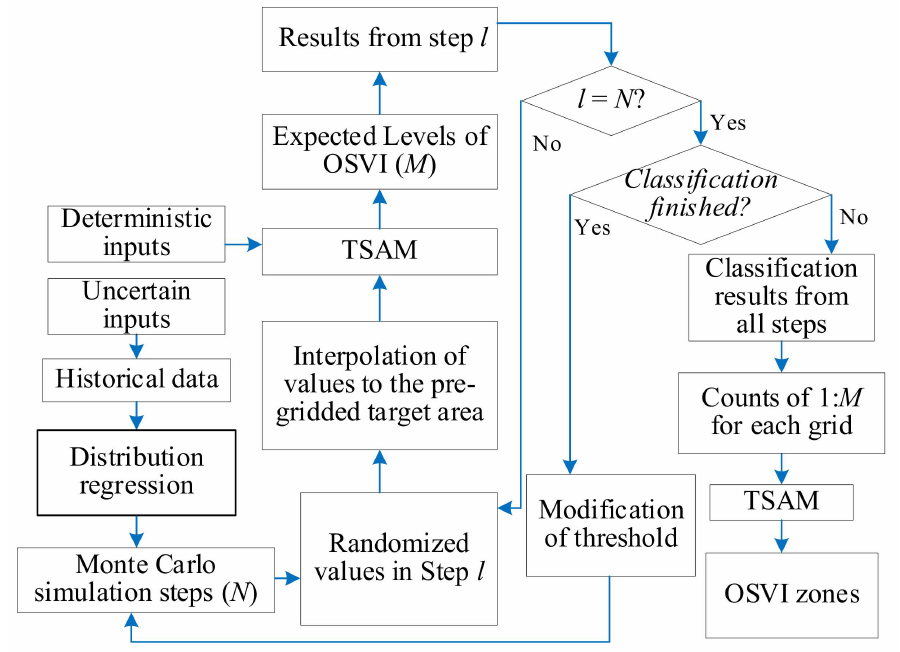
Figure 1. Framework of the MC-TSAM approach (adopt from Li et al. (2014)